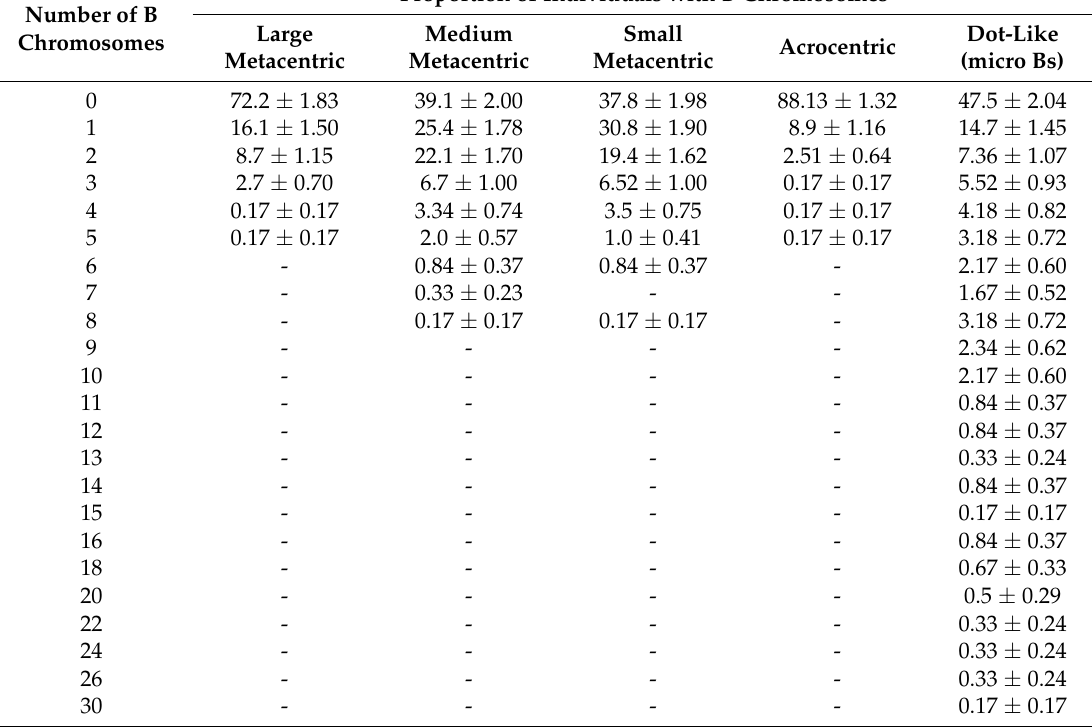
Table 3. Proportion of A. peninsulae individuals with different number of B chromosomes (%, ± SE) over the species